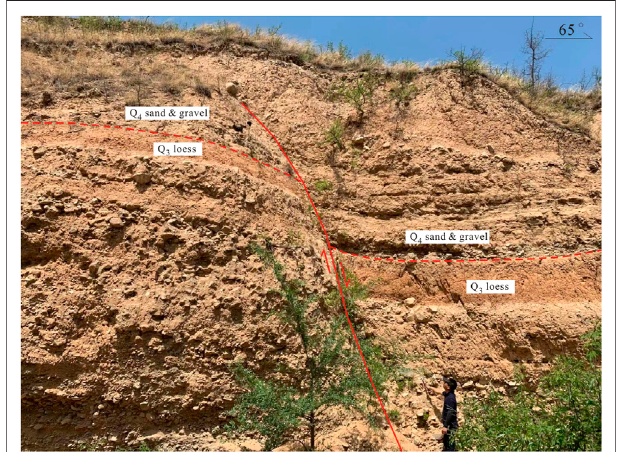
FIGURE 2 | ENE-striking normal fault (F 10 , refer to Figure 1 , N 14 , for the location). The Late Pleistocene (Q 3 ) loess was cut by the fault, indicating the latest active age.